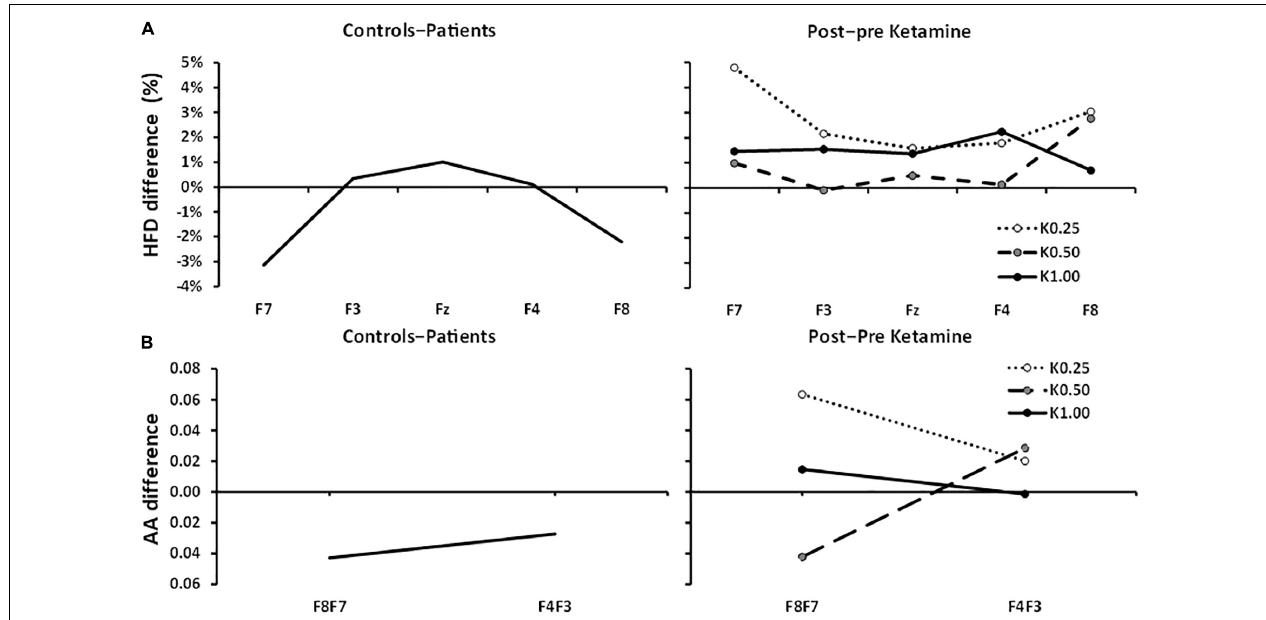
FIGURE 3 | Controls–patients and post–pre ketamine HFD and AA differences across frontal channels. (A) HFD: Controls–patients displays a significant U-shaped relationship between HFD change and frontal channels. 0.25, 0.5, and 1.0 mg/kg of ketamine produced no significant HFD effects and any trend is in the opposite direction. (B) Controls–Patients FAA differences were not significant at F8:F7 and F4:F3 pairs. Post–pre ketamine FAA was not significantly different across 0.25, 0.50, and 1.00 mg/kg doses at F8:F7 and F4:F3 pairs.